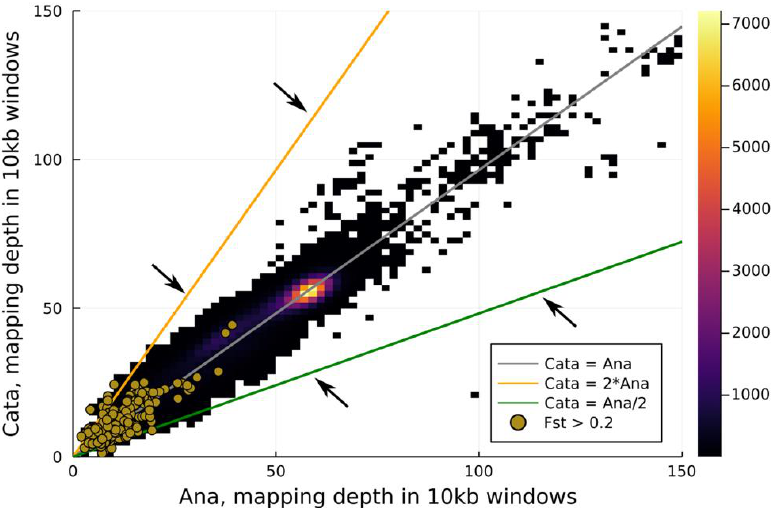
Figure 6. Histogram of average mapping depths in windows of 10 kb between the ana and cata pools. The colour bar on the right corresponds to tile colours in the main plot and indicates the number of windows in a certain mapping depth class. Windows with F ST values > 0.2 are indicated by gold dots. The orange and green lines indicate mapping depth ratios between the ana and cata pools of 2 and 1/2, respectively. The position of the arrows indicate the points where hemizygous sequences are expected in either of the morphs.